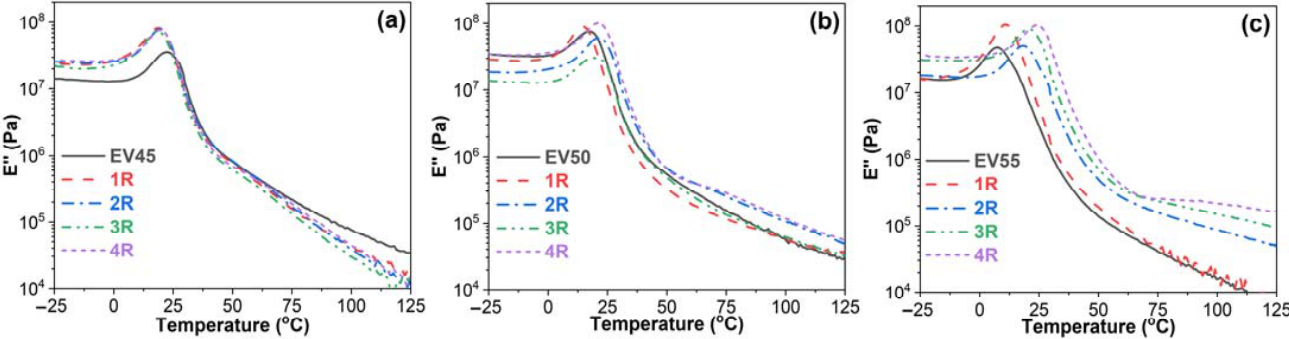
Figure 8. Loss modulus versus temperature curves of the original and recycled epoxy vitrimers: ( a ) EV45, ( b ) EV50 and ( c ) EV55. ( a ) EV45, ( b ) EV50 and ( c )